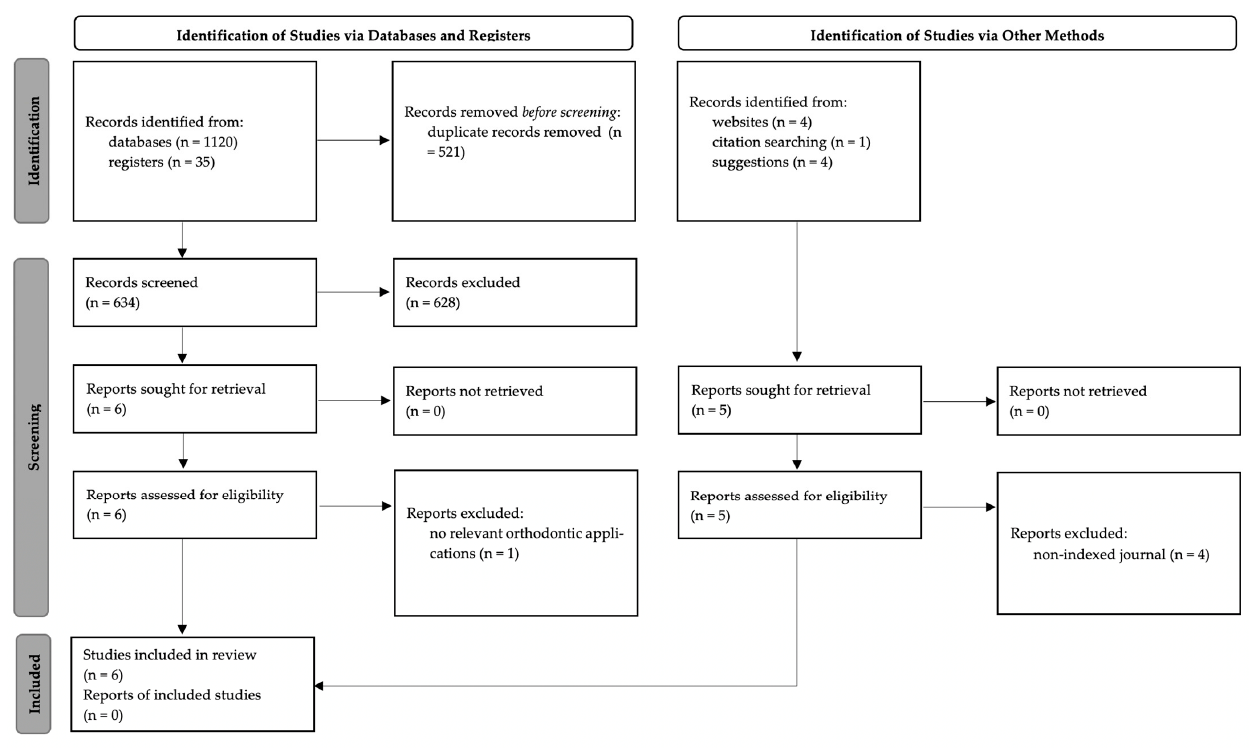
Figure 1. PRISMA flowchart [20] showing the study selection process.